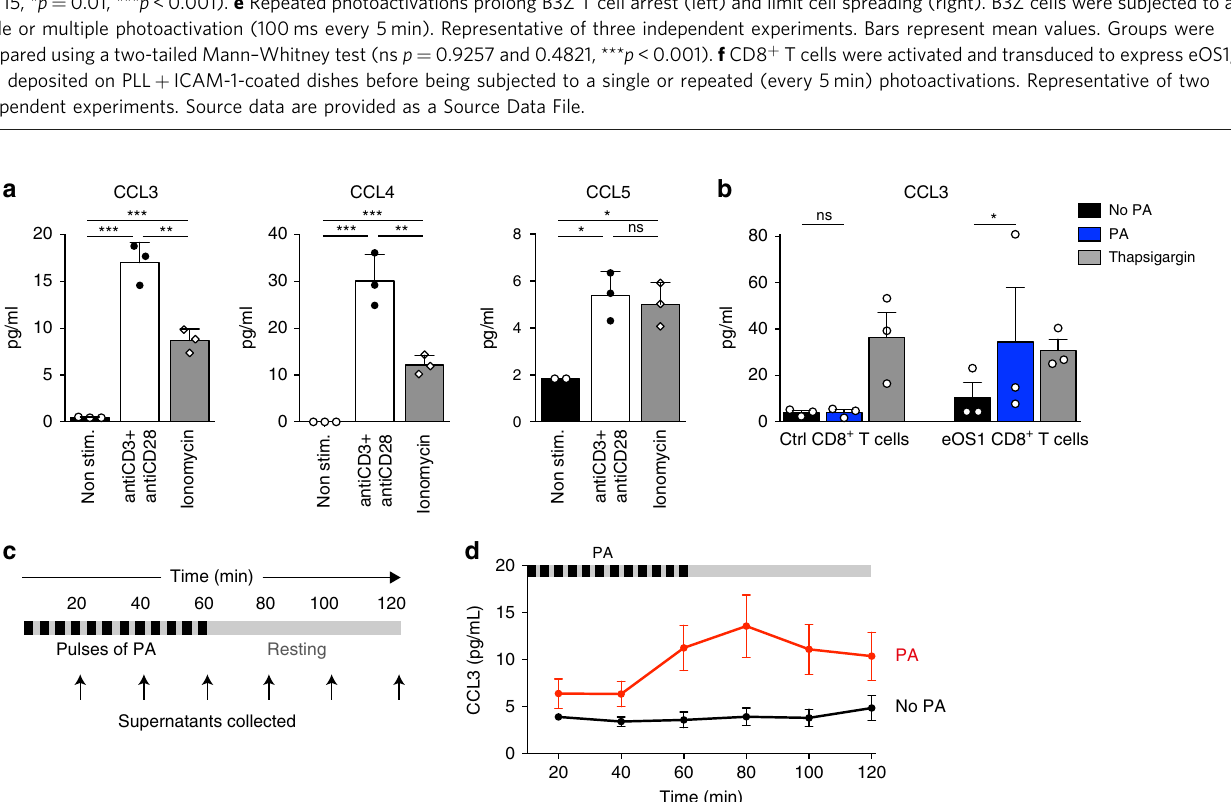
Fig. 3 The eOS1 actuator allows to control the rapid chemokine release in T cells. a Effector primary CD8 + T cells were stimulated for 1 h at 37 °C with anti-CD3 + anti-CD28-coated antibodies or with ionomycin or were left unstimulated. Supernatants were recovered and the secretion of the chemokines CCL3, CCL4, and CCL5 were measured using a mouse cytokine multiplex assay. Representative of two independent experiments. Results are shown as mean ± SEM. Dots correspond to experimental replicates. Statistical signi fi cance was assessed using a two-tailed unpaired t -test (* p < 0.05, ** p < 0.01, *** p < 0.001). b Primary CD8 + T cells were transduced with eOS1 (or with eGFP as a control) and the calcium pathway was stimulated for 1 h either by photoactivation or thapsigargin. The secretion of CCL3 was measured in the supernatants by ELISA. Results are compiled from three independent experiments (each dot represents one experiment, histograms show mean ± SEM). Groups were compared using a ratio paired t -test. (* p < 0.05). c , d Kinetic of CCL3 secretion after photoactivation. Primary CD8 + T cells transduced with eOS1 were photoactivated with 5 s pulses of light every 5 min during 1 h and left non photoactivated for an additional hour. Supernatants were collected every 20 min and replaced by warm medium. c Experimental setup. d CCL3 secretion was measured by ELISA in the supernatants of photoactivated cells (red curve) or control non photoactivated cells (black curve). The results of three independent experiments are pooled and shown as mean ± SEM. Source data are provided as a Source Data